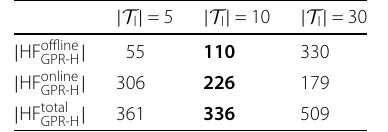
| and effective GPR-H